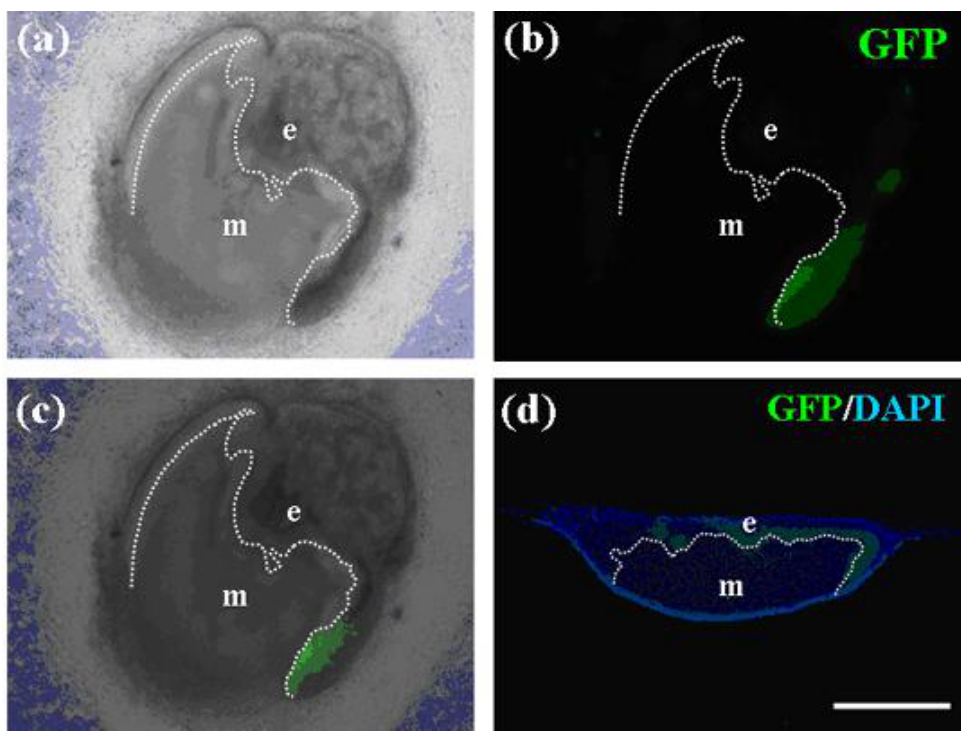
Figure 13. Immunohistochemistry of teeth developed from germs cultured for seven days. ( a ) Bright field photo of a constructed tooth with a pellet of GFP-labeled emtg-2 cells and a pellet of EC and with MT. ( b ) Immunohistochemistry with anti-GFP antibody detected GFP-labeled cells in an enamel organ (green). ( c ) ( a ) and ( b ) were marged. GFP-labeled emtg-2 cells were detected in cervical loop area. ( d ) Immunohistochemistry with anti-GFP antibody detected GFP-labeled cells in epithelium at right side in the section of ( a ). Nuclei were stained with DAPI (blue) in ( d ). dot line; basement membrane, e: epithelium, m: mesenchyme. (cid:54)(cid:70)(cid:68)(cid:79)(cid:72)(cid:3)(cid:69)(cid:68)(cid:85)(cid:3)(cid:76)(cid:86)(cid:3)(cid:24)(cid:19)(cid:19)(cid:3)(cid:541)(cid:80)(cid:3)(cid:76)(cid:81)(cid:3)(cid:11) d ) and all figures are at the same